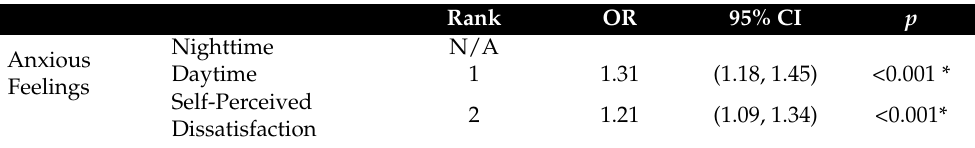
Table 4. Forward Stepwise Regression Analysis of Insomnia Components Associated with Each Anxiety Symptom, Adjusted for